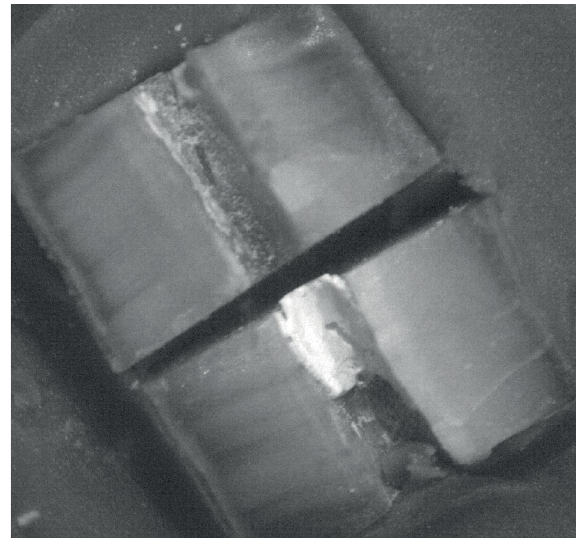
Figure 3. Failure mode classified as adhesive. Figure 4. Failure mode classified as mixed.